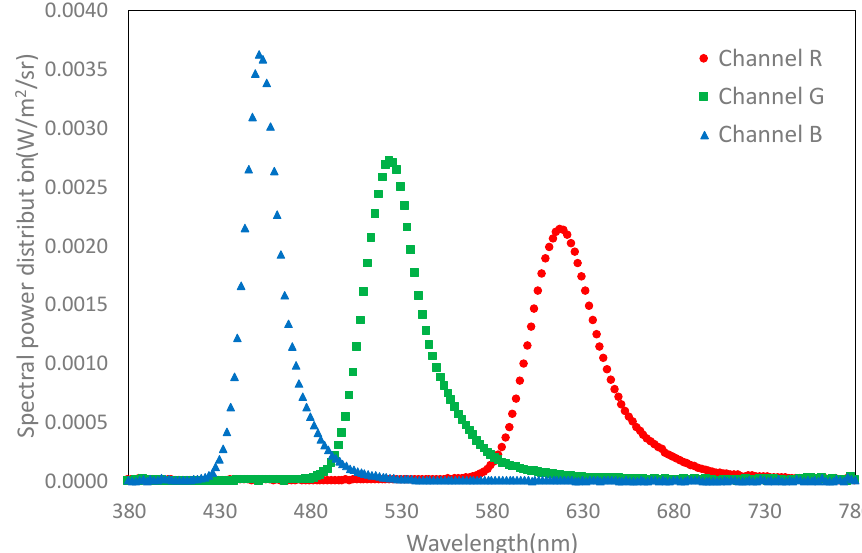
Figure 3. Spectral power distribution of the RGB channels measured at the maximum digital-to-analog converter (DAC) value.